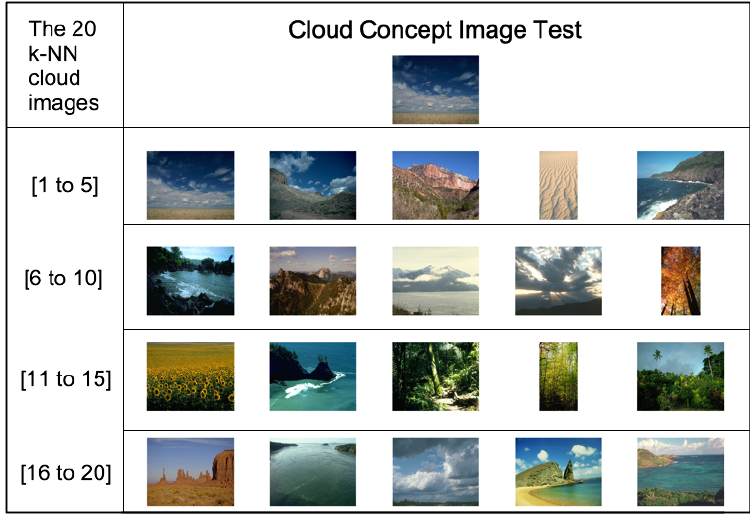
Figure 16. Retrieval results related to the concept of